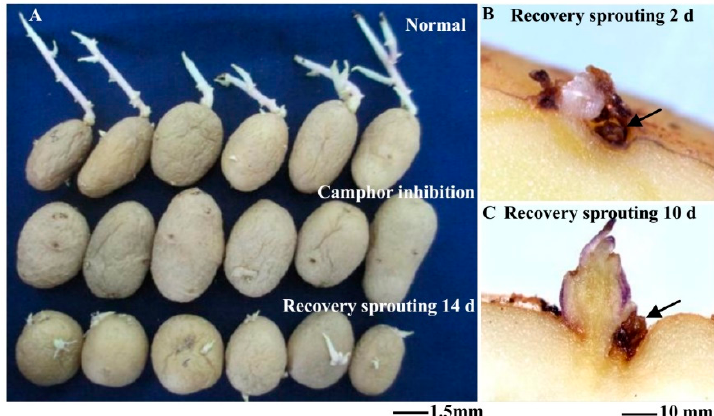
Figure 2. Recovery sprouting after moving to ventilation conditions for 2 d, 10 d and 14 d. ( A ) Comparison of shoot growth under different treatments; ( B ) New sprout growth from the bud eye region after recovery sprouting for 2 d; ( C ) New sprout growth from the bud eye region after recovery sprouting for 10 d. Arrows indicated the original dead bud tissue.